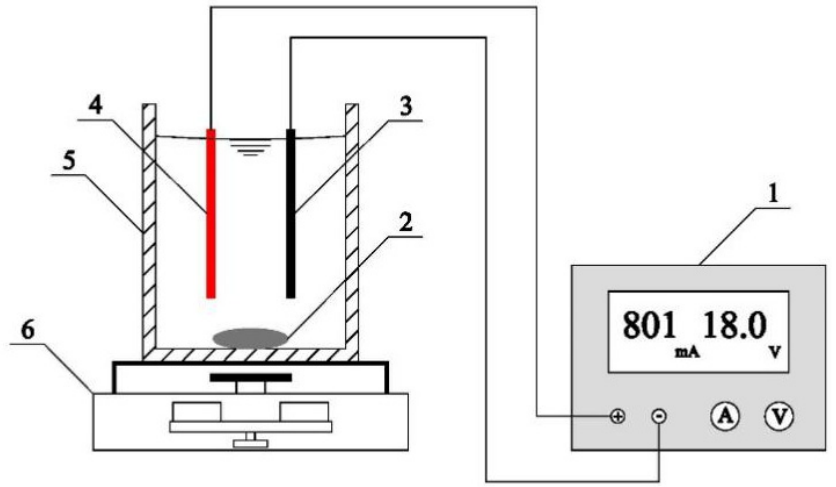
Figure 1. Schematic diagram of electrochemical cell lysis static experimental setup. 1. DC stabilized power supply; 2. Stir bar; 3. Titanium cathode; 4. Titanium coating electrode (anode); 5. Electrolytic cell; 6. Magnetic stirrer.